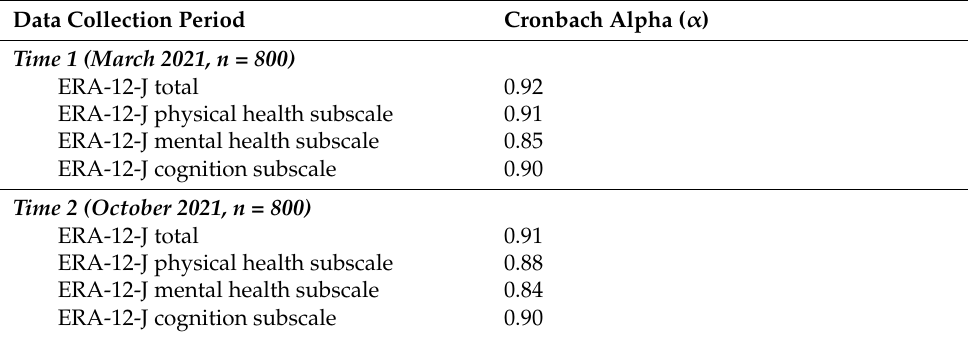
Table 2. Internal consistency